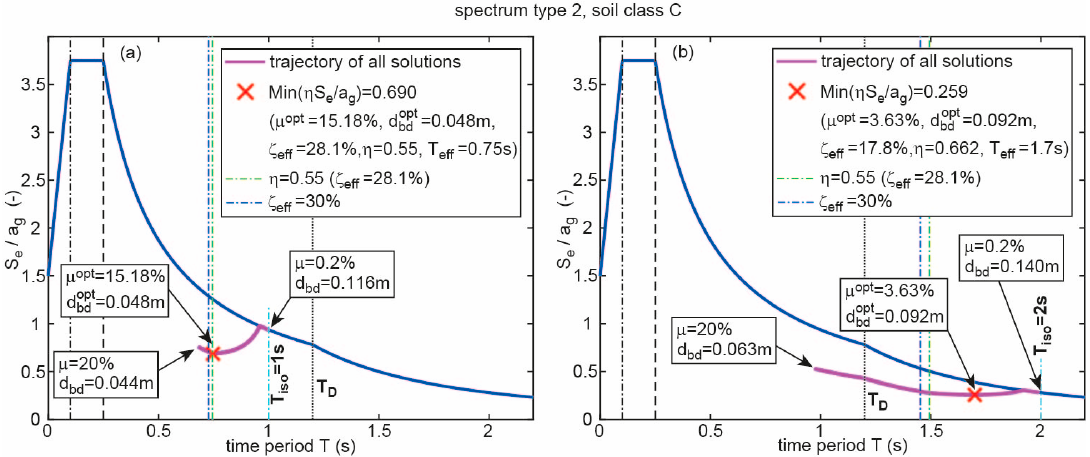
T = 1 s and ( b ) T = 2 s for spectrum type 2 with iso iso